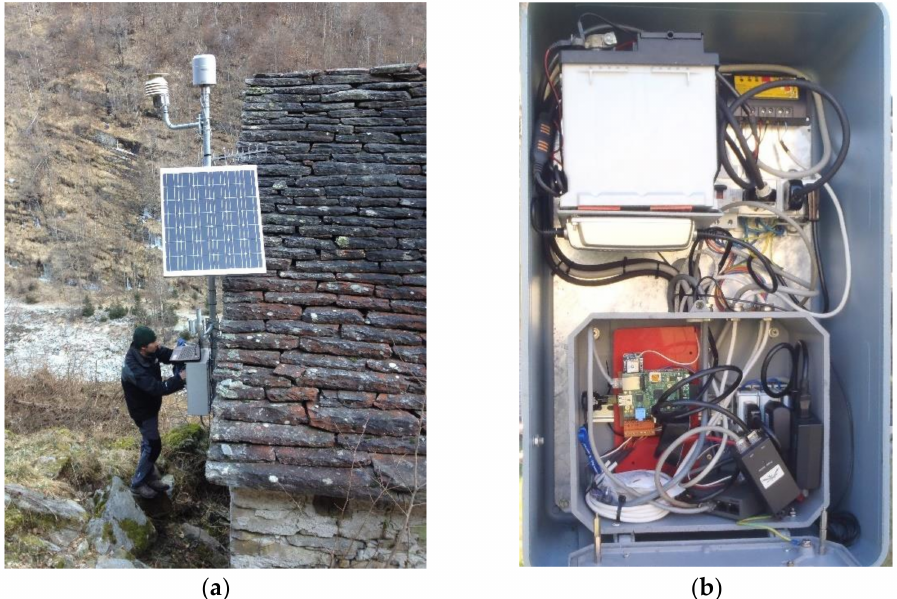
Figure 4. Meteorological station of Craveggia: ( a ) pluviometer, solar panel, and robust shell; ( b ) de- tailed contents of the shell: battery, modem, various electronic